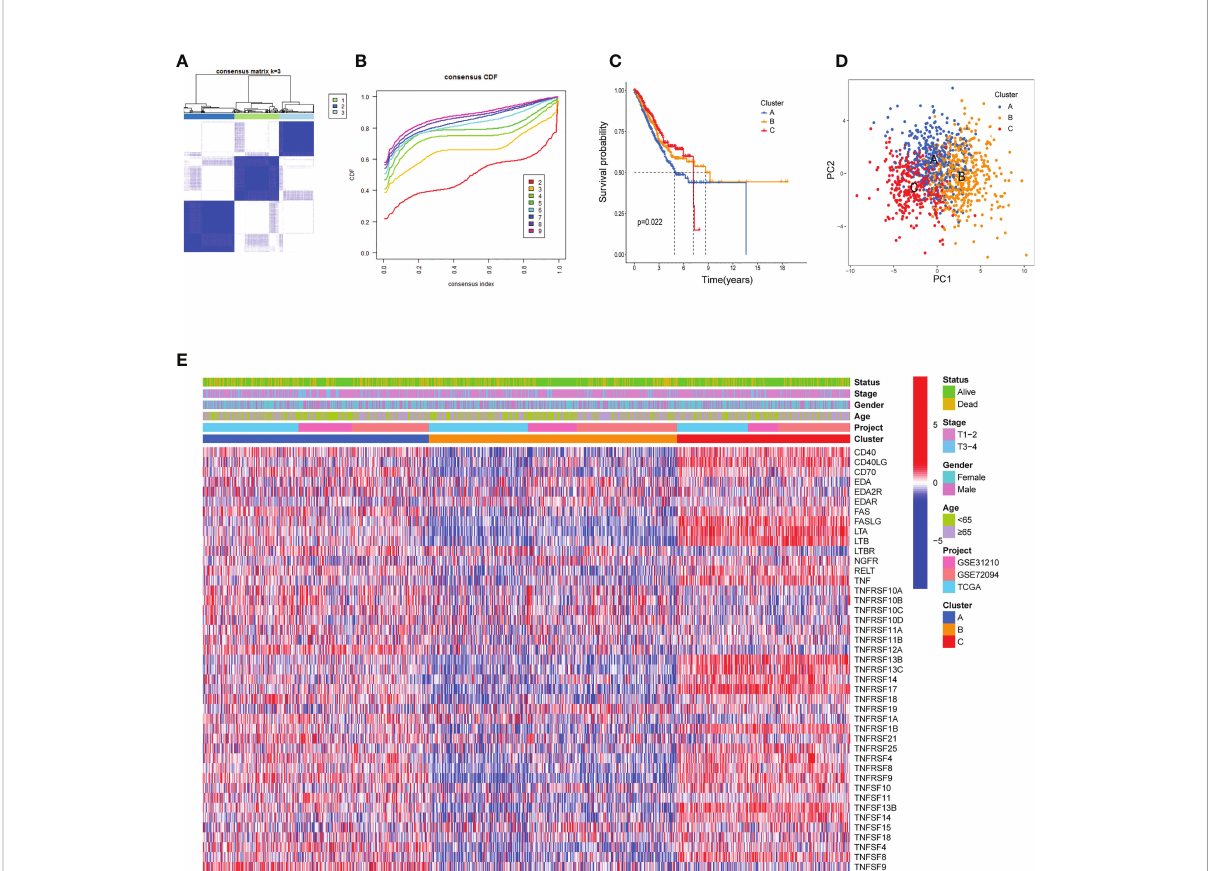
analysis between the three clusters. (E) Heatmap shows the relationships between clinicopathological characteristics of the patients and the three